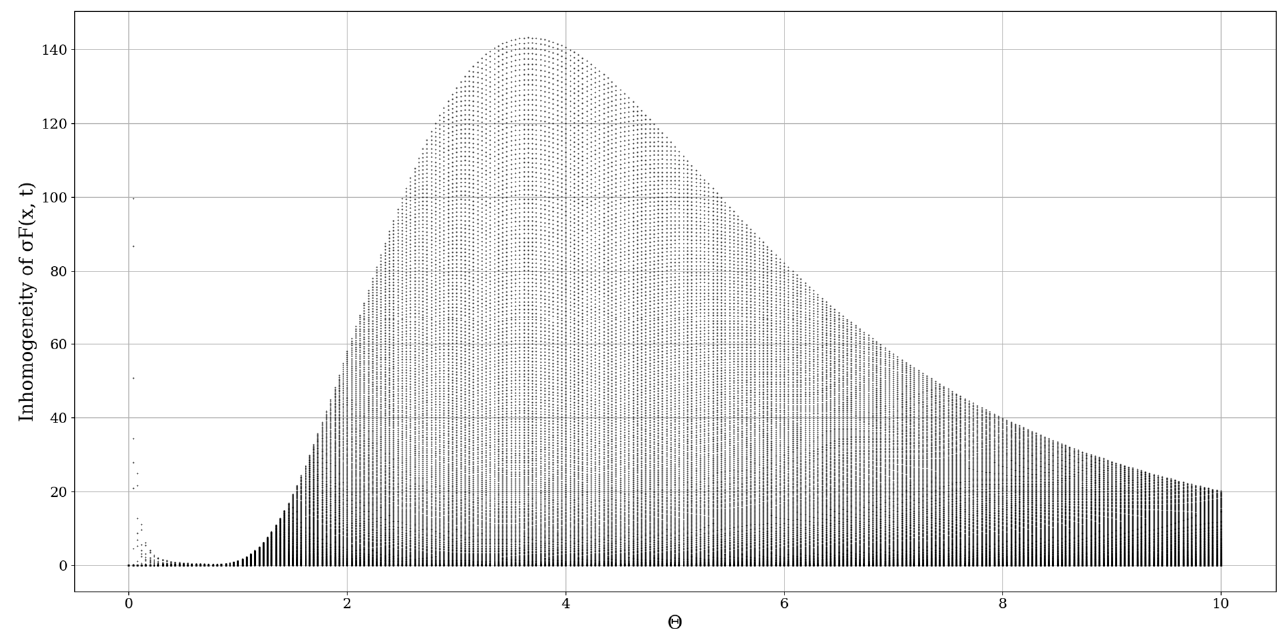
(cid:48) 2 (cid:105) Figure 6. (cid:104)| σ F | example plot with θ as control parameter; ξ = 3; µ = Figure 6. 〈|σ (cid:2890) (cid:3364)(cid:3364)(cid:3364)| (cid:4593)(cid:2870) 〉 example plot with θ as control parameter; ξ = 3 ; μ = 1 .